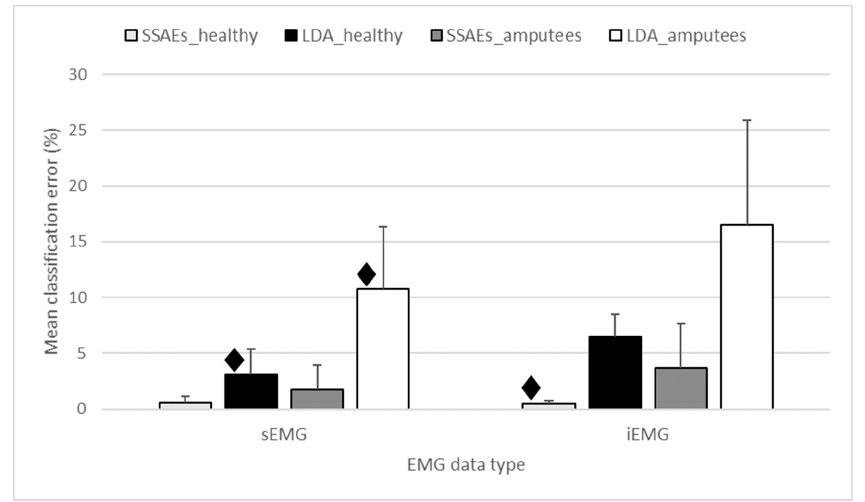
Figure 6. Mean (and SD) classification error obtained with two different classifiers for both kinds for healthy and amputee subjects. The diamond symbol indicates the best EMG data type, with statistical significance.